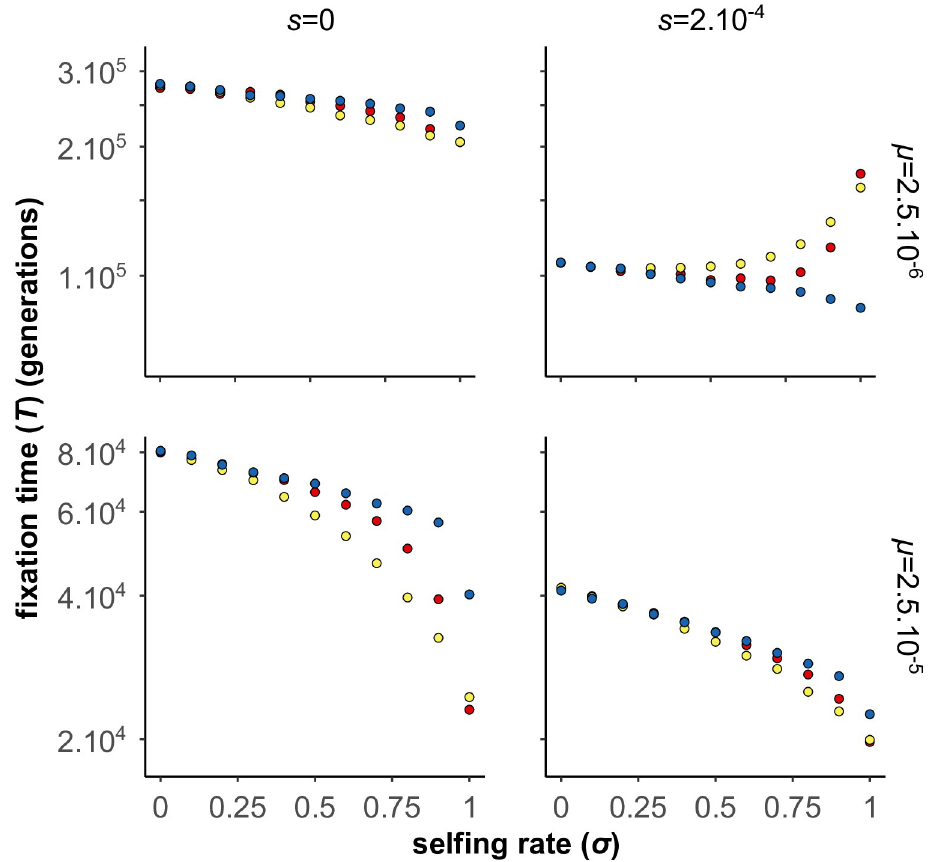
Fig 8. Effects of background selection on the accumulation of BDMi mutations (two-locus model). The graph displays the fixation time, either without (left) or with (right) selection on the derived alleles, and under different scenarios of background selection, ‘linear BG effects’ (yellow) or ‘curved BG effects’ (red), which we compared to a scenario without background selection (blue) (see methods for details on the implementation of background selection effects in our simulations). N = 10, 000, h = 0.5, s = 2.5.10 − 4 , h b = k b = 0.5, s b = 10 − 3 , r = 0.5. 10, 000 iterations.